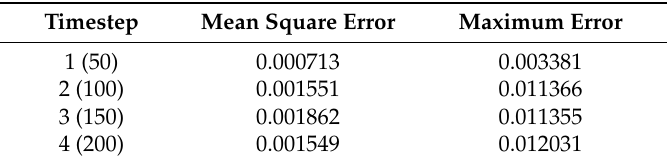
Figure 11. Prediction of length fitting results. Table 3. Predicted length results.